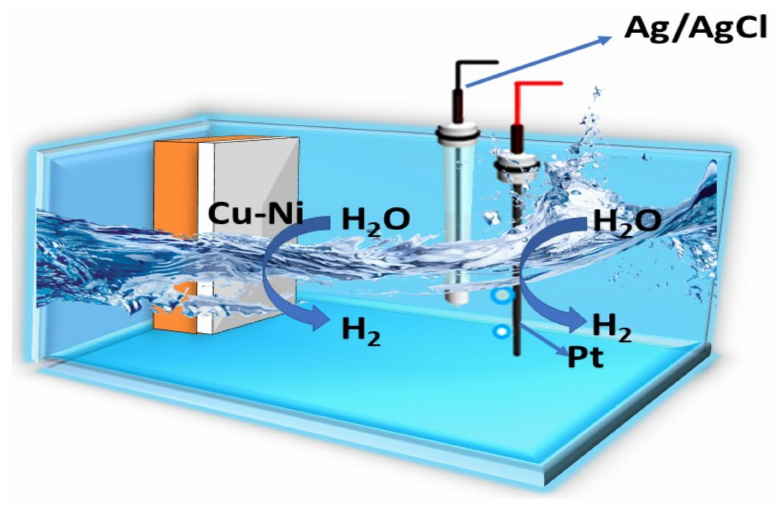
Figure 9. Schematic image of the